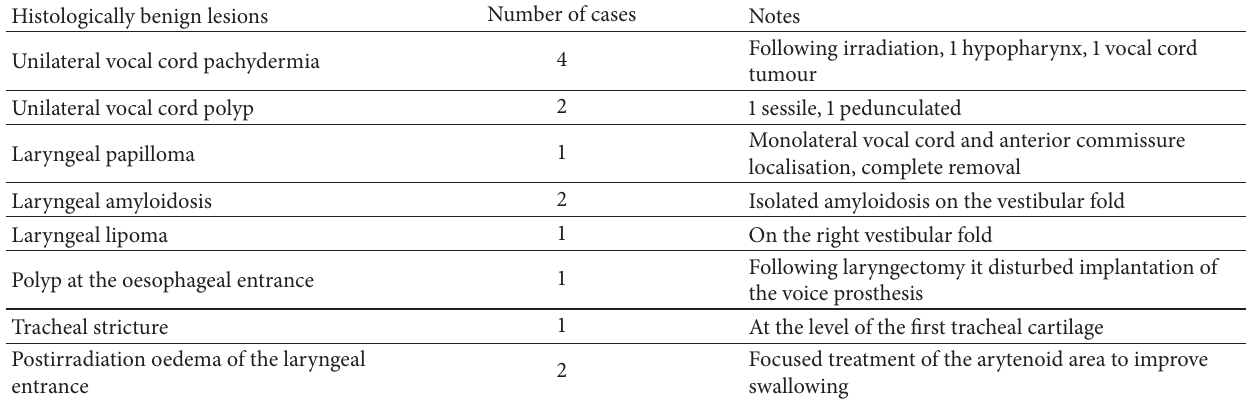
Table 1: Histologically benign lesions and our